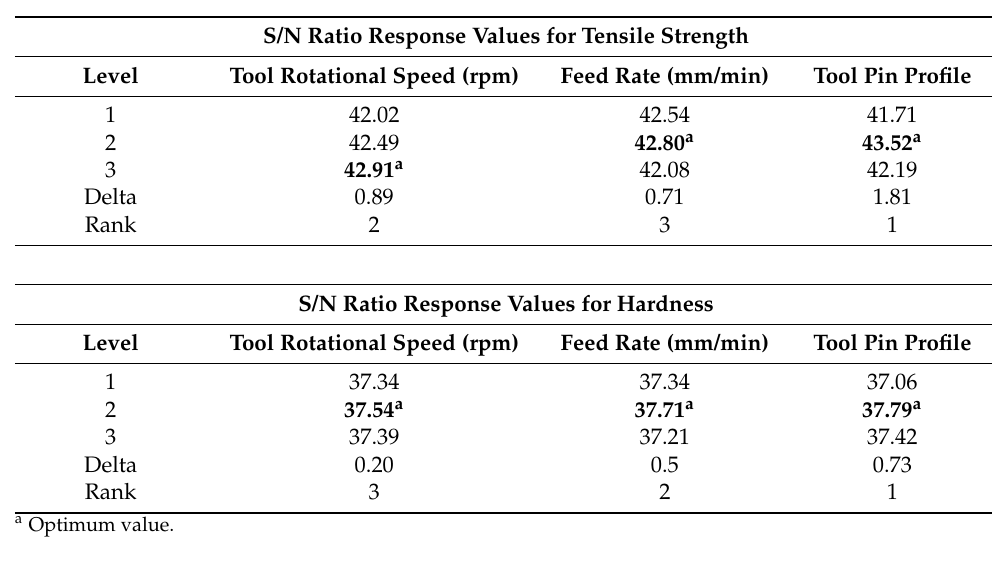
Figure 4. Main effect plot of signal-to-noise ratio for tensile strength. Table 5. Tensile strength and hardness S/N